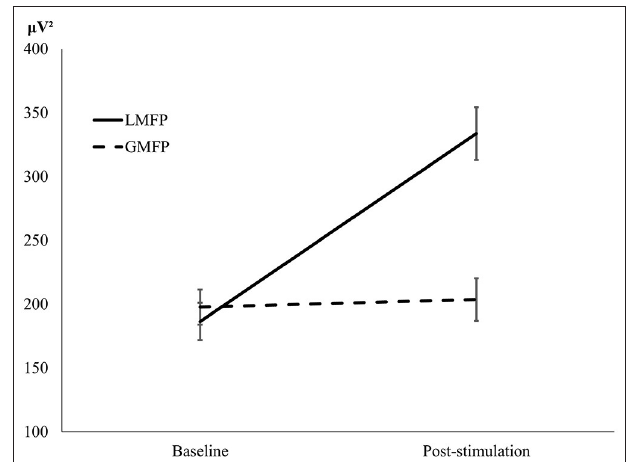
FIGURE 2 | L-IPL. Graphical representation of LFMP and GFMP at baseline and after stimulation.